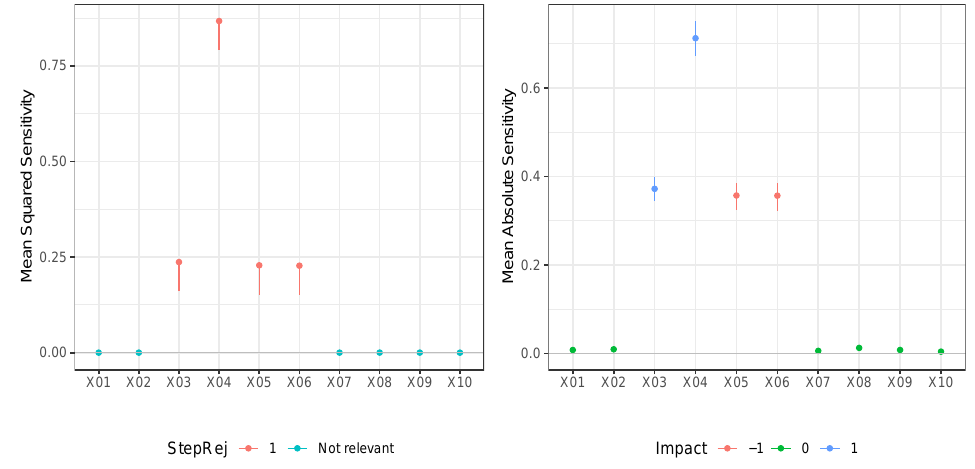
Figure 2. Model M1 (Tibishirani). Case n = 1000. ( left ) Values of test statistic T n and critical values T n − ˆ c ( 1 − α , k ) . ( right ) Values of mean absolute sensitivity along with bootstrap confidence limits with B = 1999 bootstrap replicates and nominal level 1 − α = 0.90 for relevant variables to the model.